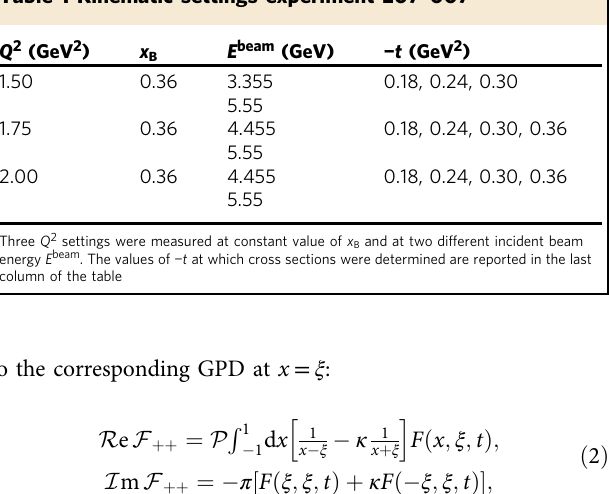
Fig. 2 Lowest-order diagrams for ep → ep γ . The momentum four-vectors of external particles are labeled on the left. The net four-momentum transfer to the proton is Δ μ = ( q − q ′ ) μ = ( p ′ − p ) μ . In the virtual Compton scattering (VCS) amplitude, the (spacelike) virtuality of the incident photon is Q 2 = − q 2 = − ( k − k ′ ) 2 . The Bjorken variable x fi ned as x = Q 2 /(2 q ⋅ P ). In B is de B the Bethe-Heitler amplitude, the virtuality of the incident photon is − Δ 2 = − t Table 1 Kinematic settings experiment E07 – 007